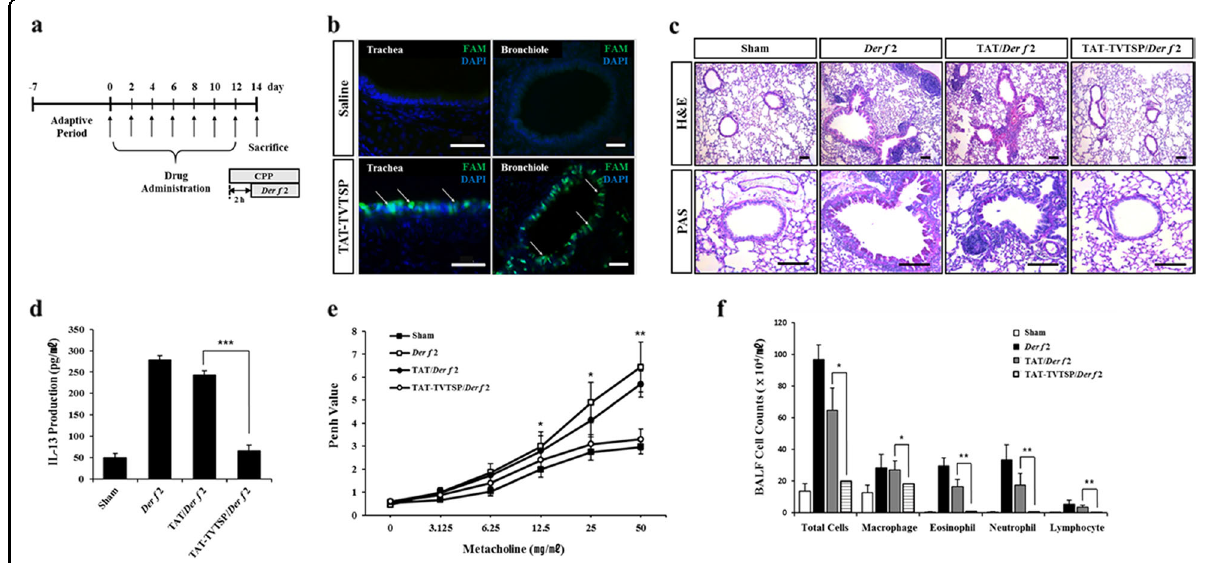
Fig. 2 Intranasally administered TAT-TVTSP ef fi ciently blocks airway in fl ammation in a Der f 2-induced acute allergic asthma model. a Schedule for the allergic airway in fl ammation model. b Saline or TAT-TVTSP-FAM (10 mg/kg) was intranasally administered in Der f 2-induced allergic asthma mouse models. After 2 h, tracheas and bronchioles were prepared for fl uorescence microscopy. Scale bar, 50 µm. c Lung tissues were sectioned and stained with hematoxylin and eosin (H&E) and periodic acid Schiff (PAS) for histological examination. Scale bar, 100 µm. d IL-13 levels in homogenates of the right lung of each mouse were measured by ELISA. The results are expressed as the means ± SD of 15 mice in each group. *** P < 0.001 compared with TAT-TVTSP + Der f 2/TAT + Der f 2. e The Penh value was determined by airway resistance to methacholine. The results are the means ± SD of 15 mice in each group. * P < 0.05 compared with TAT-TVTSP + Der f 2/TAT + Der f 2 at 12.5 mg/kg or at 25 mg/kg methacholine. ** P < 0.01 compared with TAT-TVTSP + Der f 2/TAT + Der f 2 at 50 mg/kg methacholine. f Numbers of immune cells in BAL fl uid. The data are presented as the means ± SD of 15 mice in each group. * P < 0.05 compared with TAT-TVTSP + Der f 2/TAT + Der f 2 in total cells or in macrophages. ** P < 0.01 compared with TAT-TVTSP + Der f 2/TAT + Der f 2 in eosinophils, neutrophils, or lymphocytes. All differences were assessed by Student ’ s t